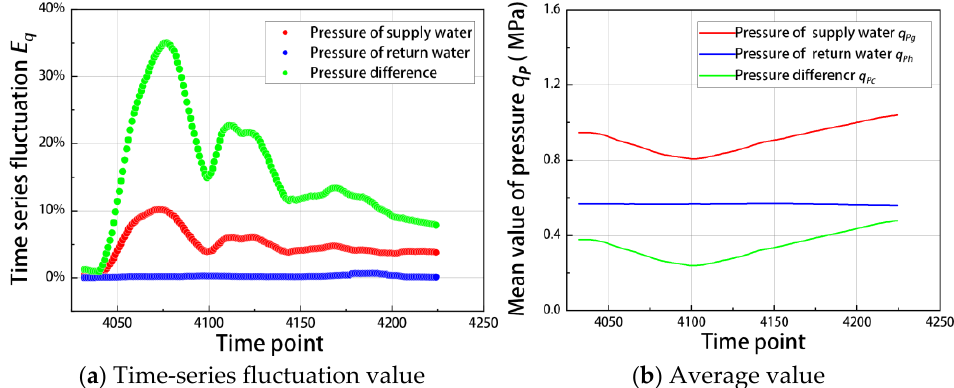
Figure 9. Time-series fluctuation value and average value of pressure. ( a ) Time-series fluctua- tion value. ( b ) Average value.